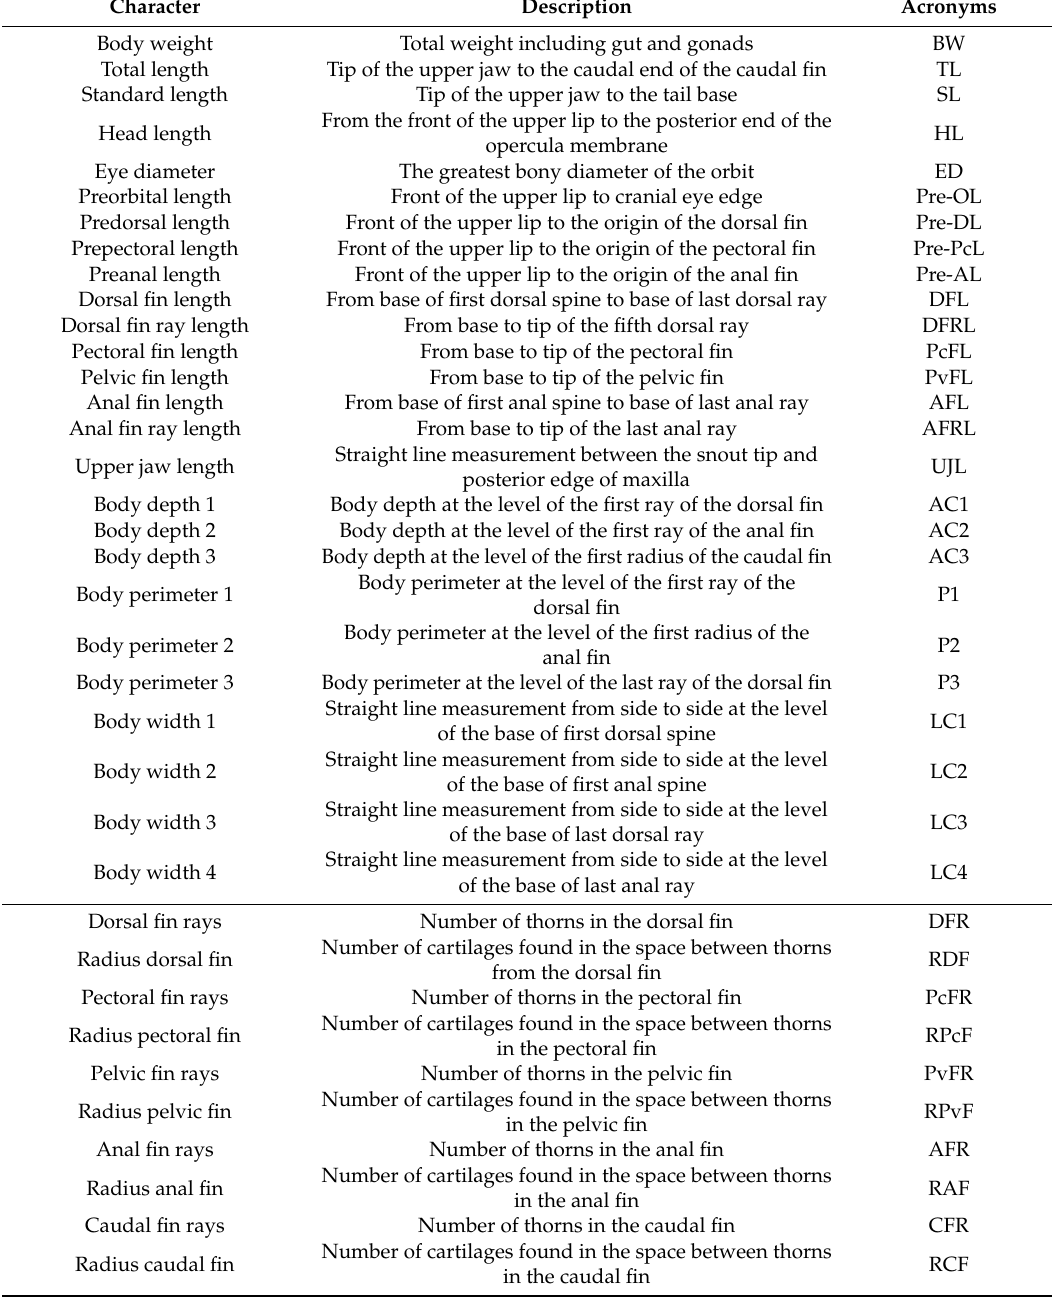
Table 1. Morphometric measurements and meristic counts of Dormitator latrifrons used in this